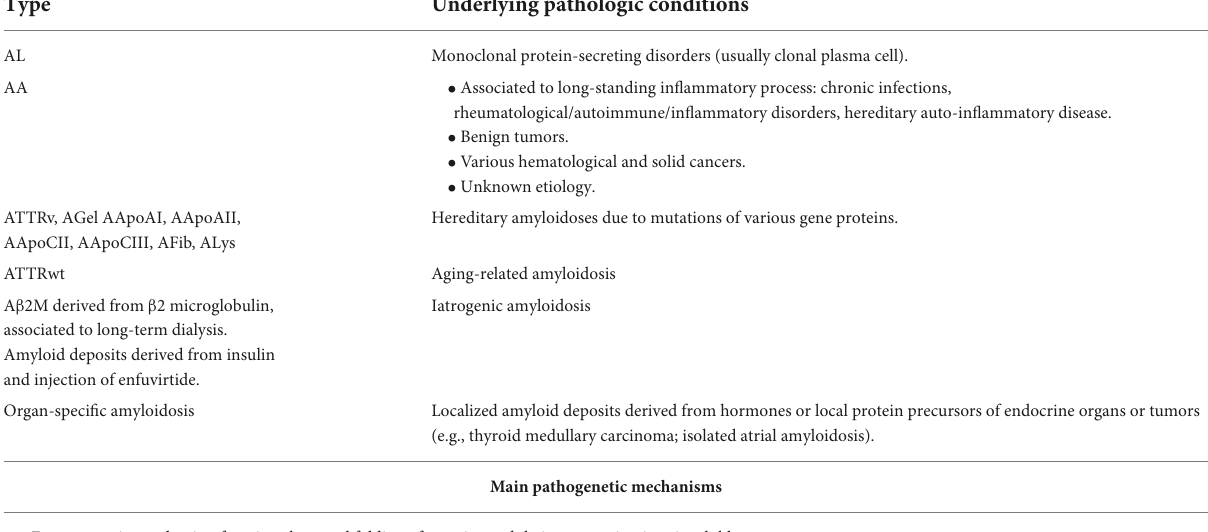
TABLE 1 Some characteristics of main types of